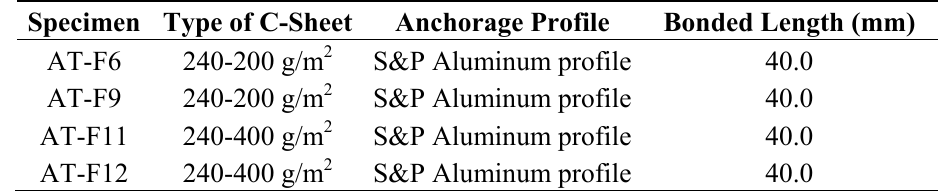
Table 7. Characteristics of Series AT-F.